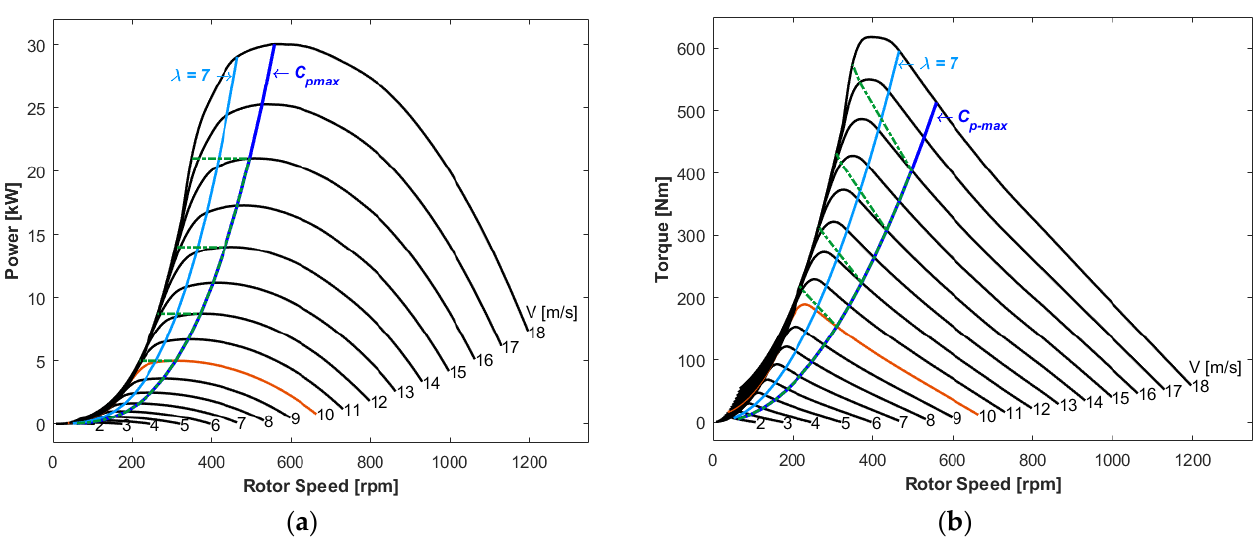
Figure 13. Performance curves including variable speed operation and maximum power tracking points for the specific wind distribution. ( a ) Power vs. rotor speed. ( b ) Torque vs. rotor speed.